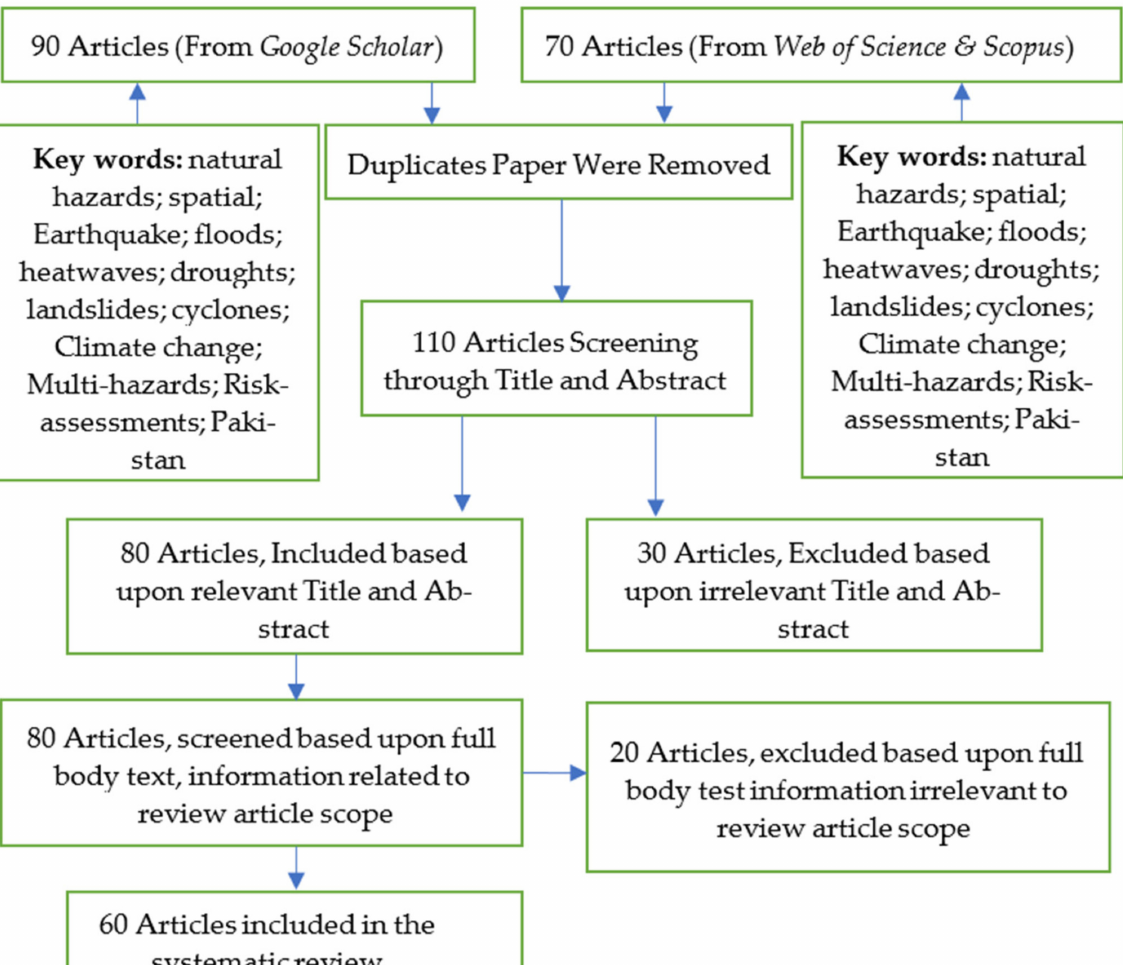
Figure 1. Search strategy for literature